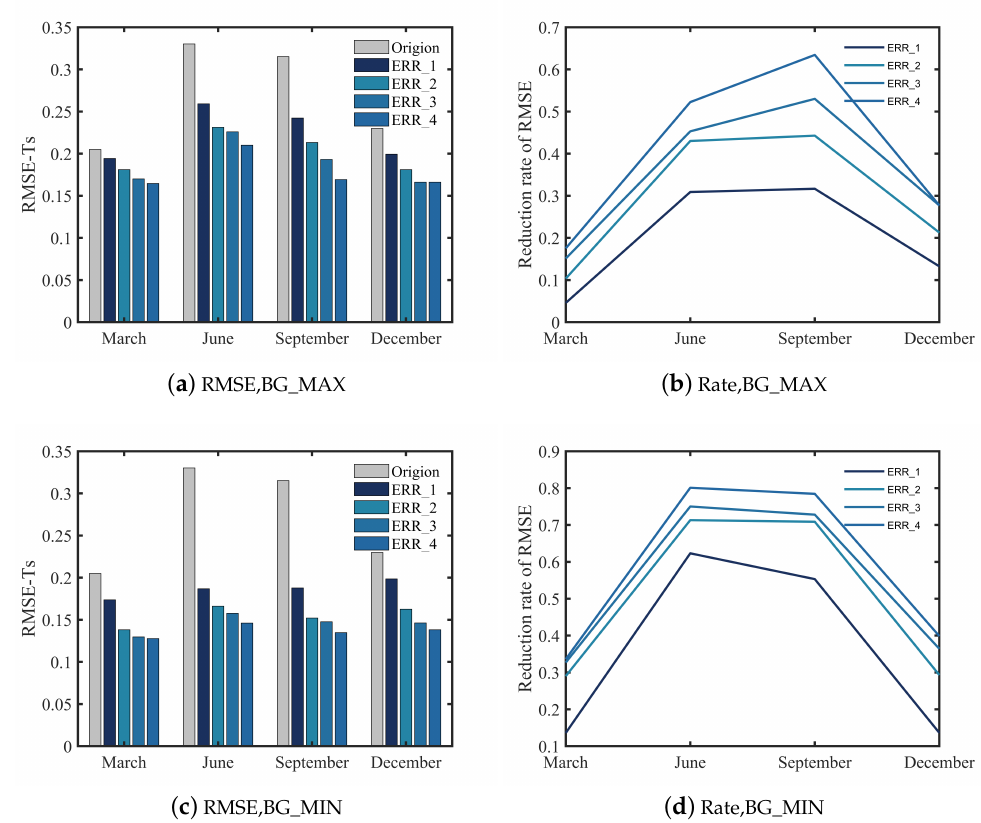
Figure 10. The mean and reduction rate of RMSE in different observation error conditions.